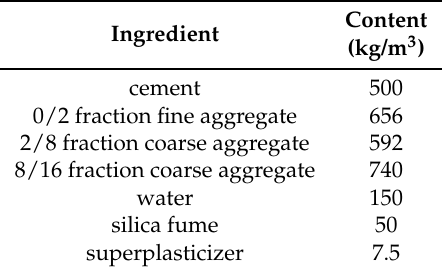
Table 3. Concrete mixture